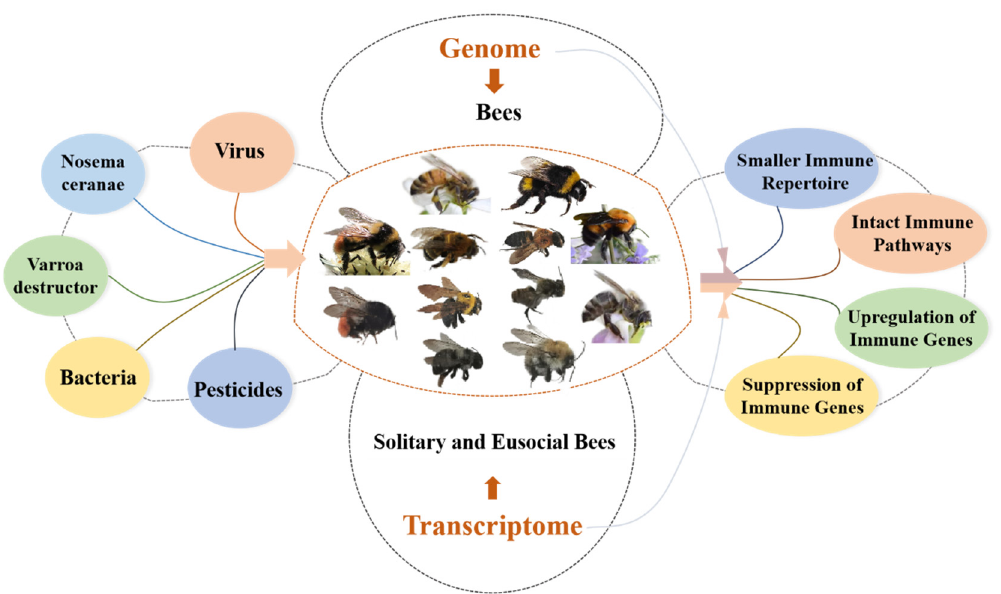
Figure 1. Overview of the innate immunity of bees from the genome and transcriptome perspectives.